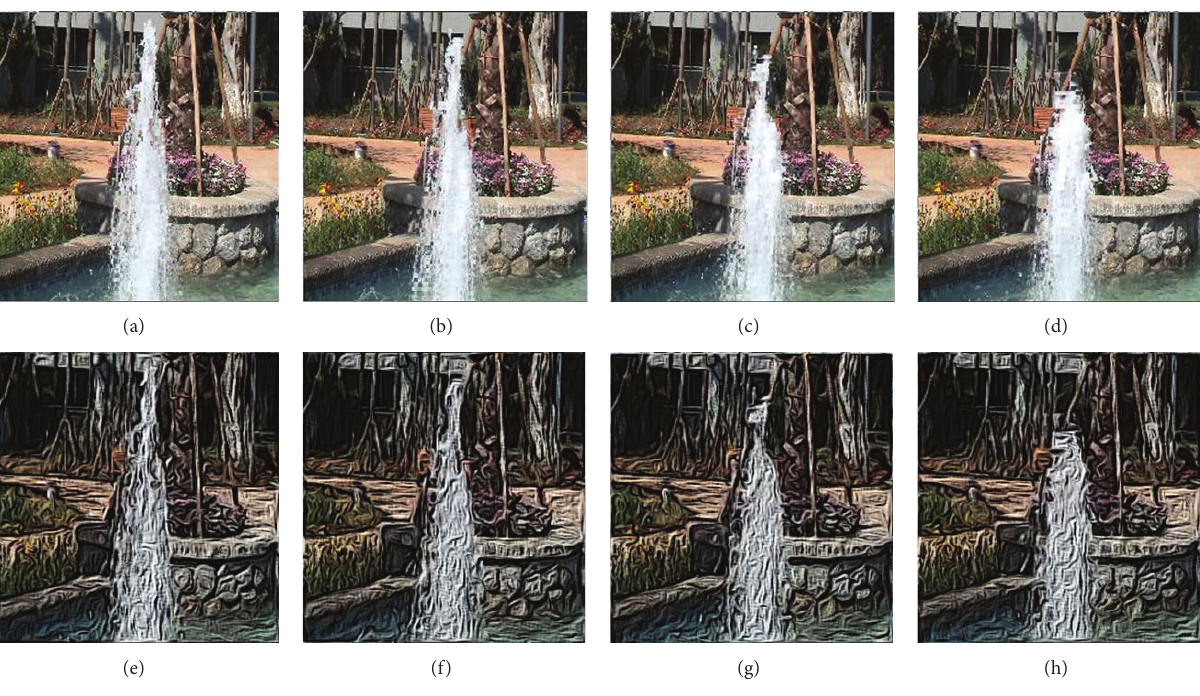
Figure 9: Video texture of